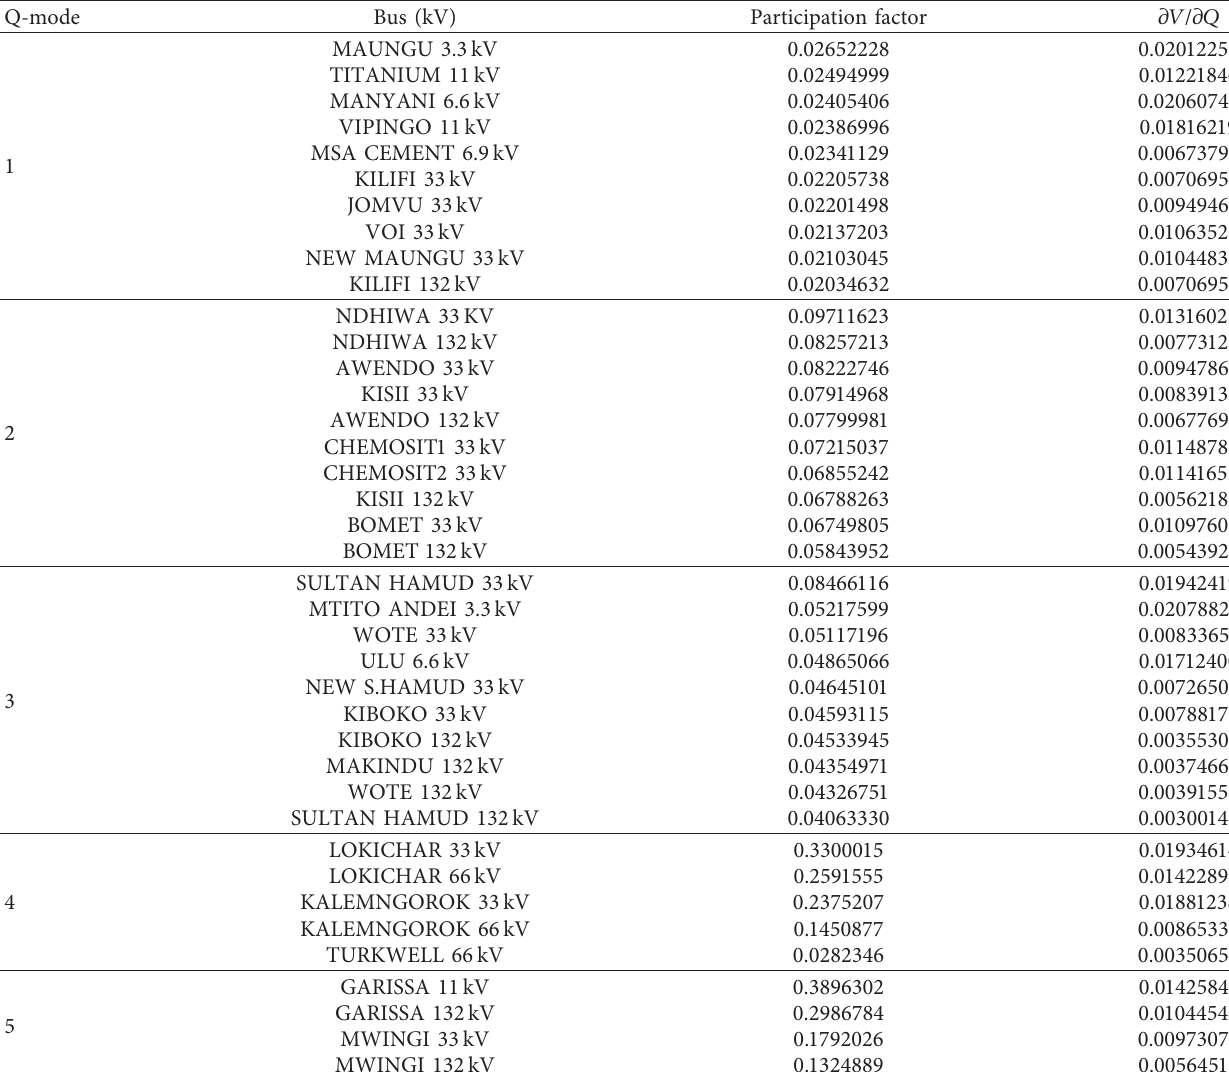
Table 5: Buses with highest participation factors in their respective Q-Modes and their corresponding VQ sensitivities. Q-mode Bus